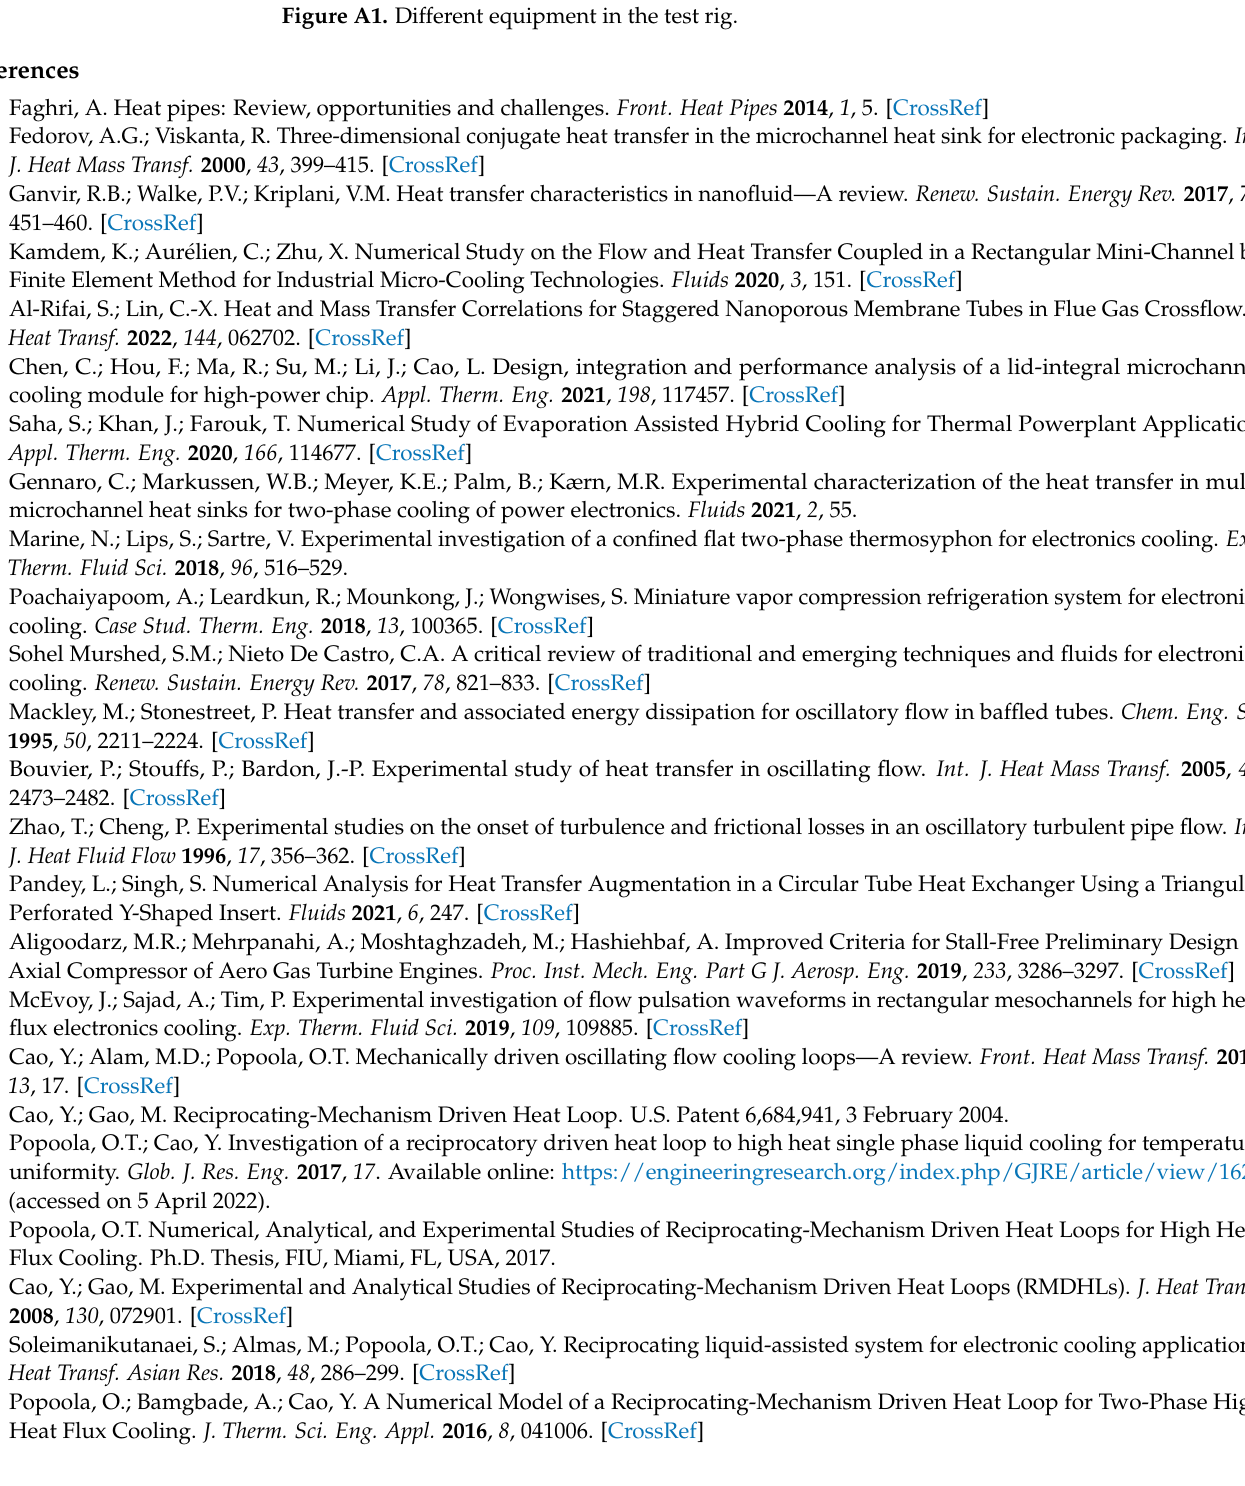
Figure A1. Different equipment in the test